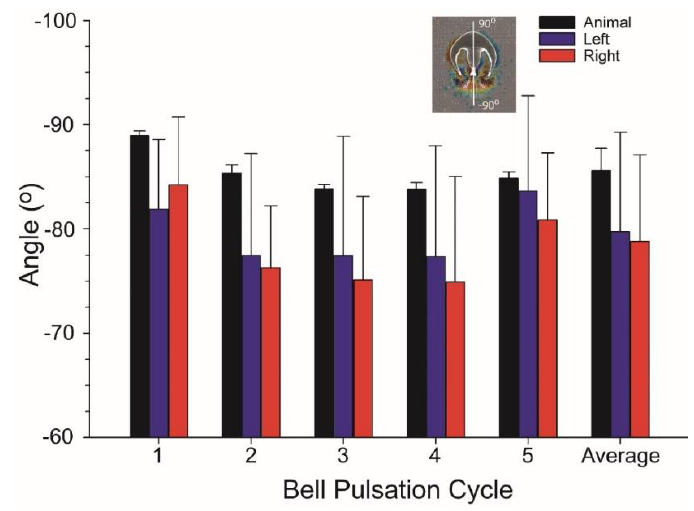
Figure 9. Orientation of animal and VIA axes for an Eutonina indicans medusa swimming with a primarily linear orientation. The convention for angular orientation values is illustrated by the inset panel of an animal with a 90, −90 ° transect line along its central axis. The left (blue) and right (red) values refer to the direction component of the corresponding VIA jets measured during pulsation cycles shown in Figures 2 and 3.